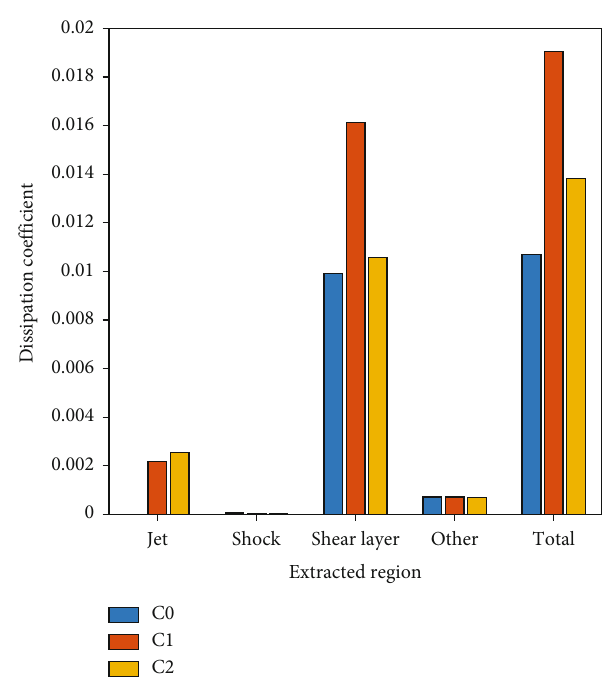
Figure 13: Dissipation component comparison of C